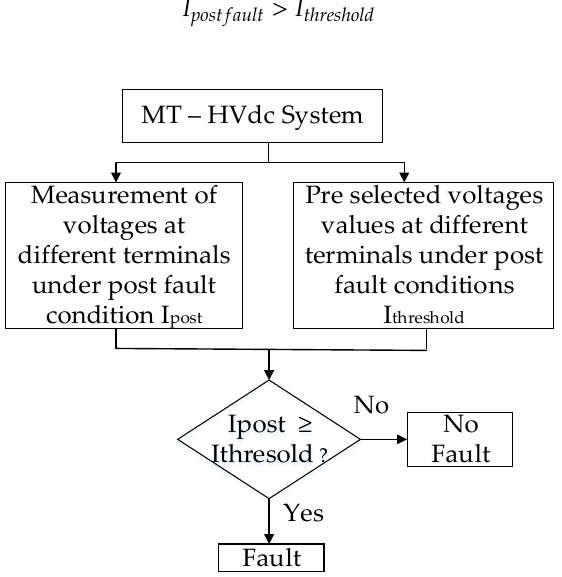
Figure 26. Non-traveling wave (NTW) method based on over current values.